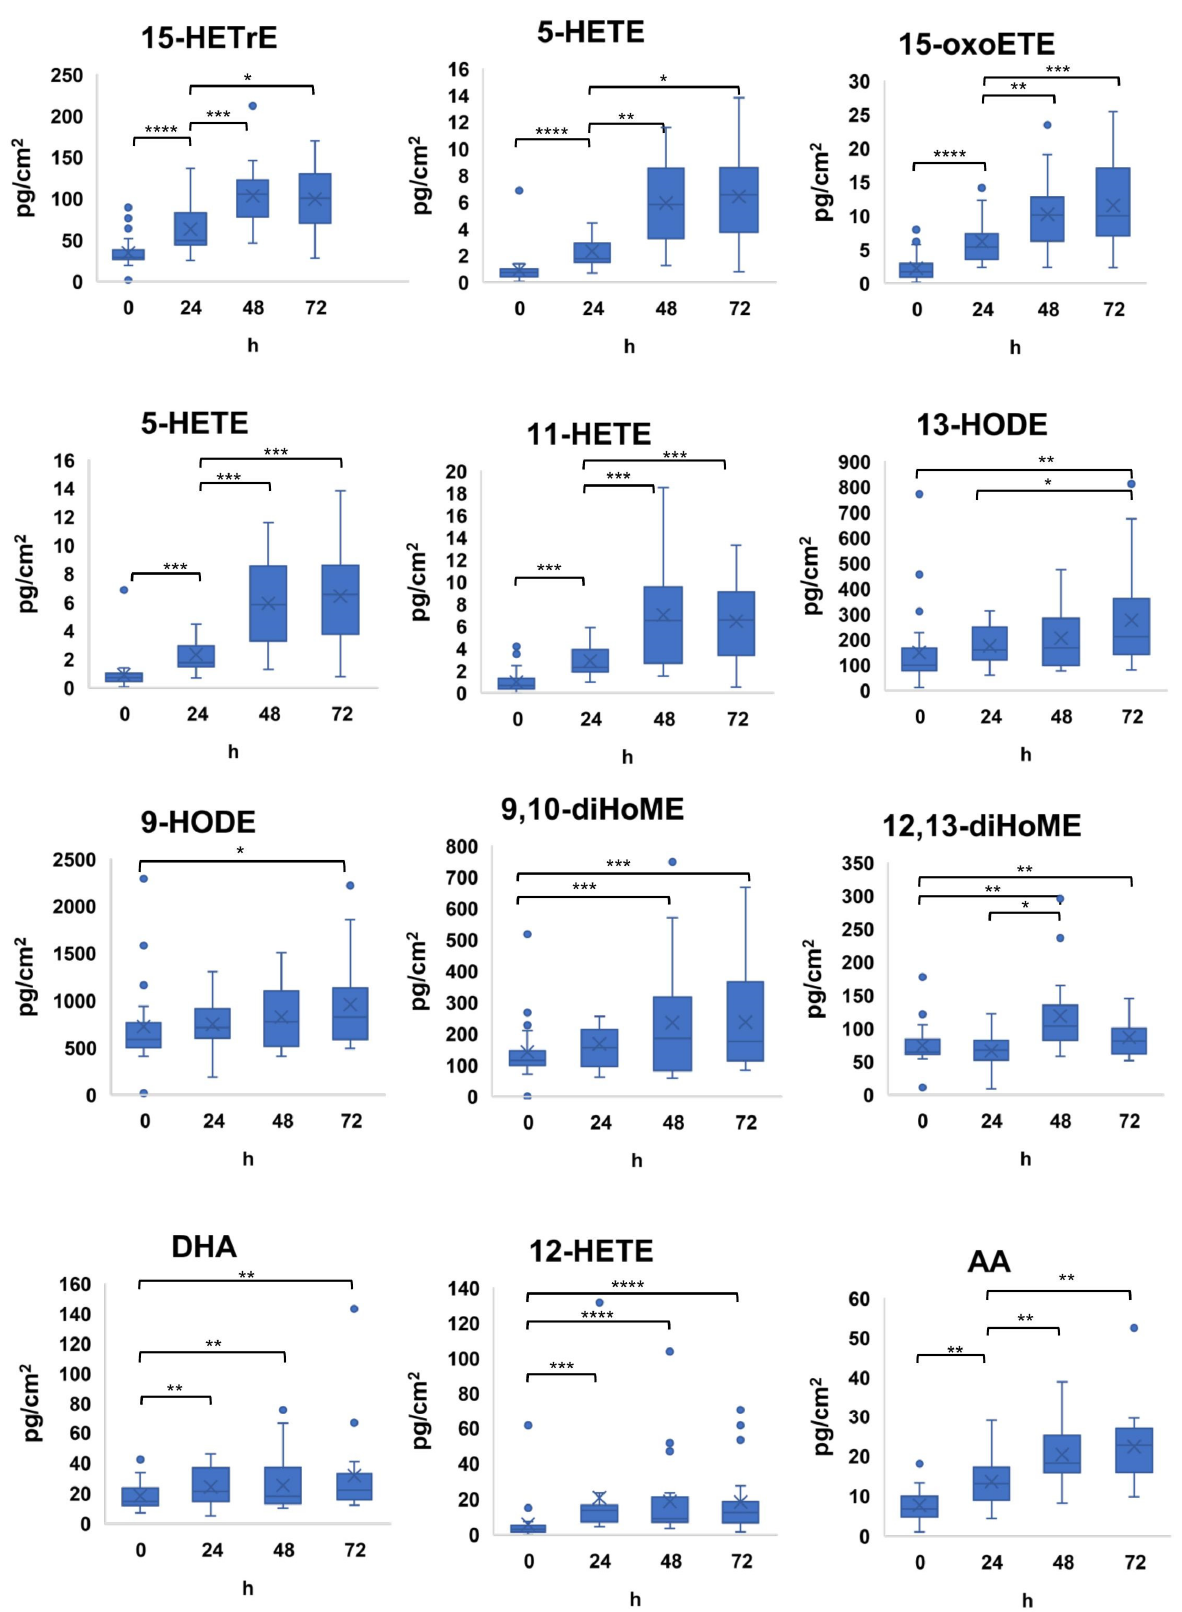
Figure 1. The results using scatter dot plots showing the median (bold horizontal line), interquartile range (box), and lipid mediator concentrations in the Y-axis across four different pre-selected time intervals (0, 24, 48, and 72 h without washing). The results are the mean ± S.E. *, p ≤ 0.05 **, p ≤ 0.01, *** p ≤ 0.001, and **** p ≤ 0.0001. h refers to